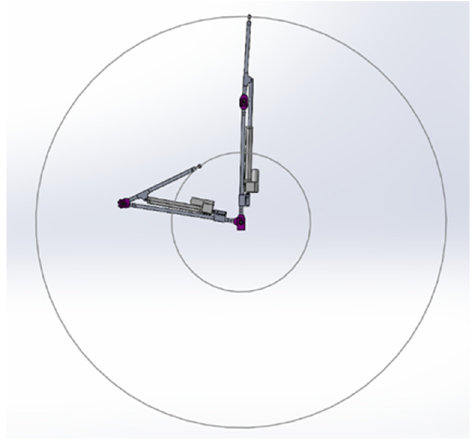
Figure 3. Representation of the workspace of each PR(RPR)RS upper view.